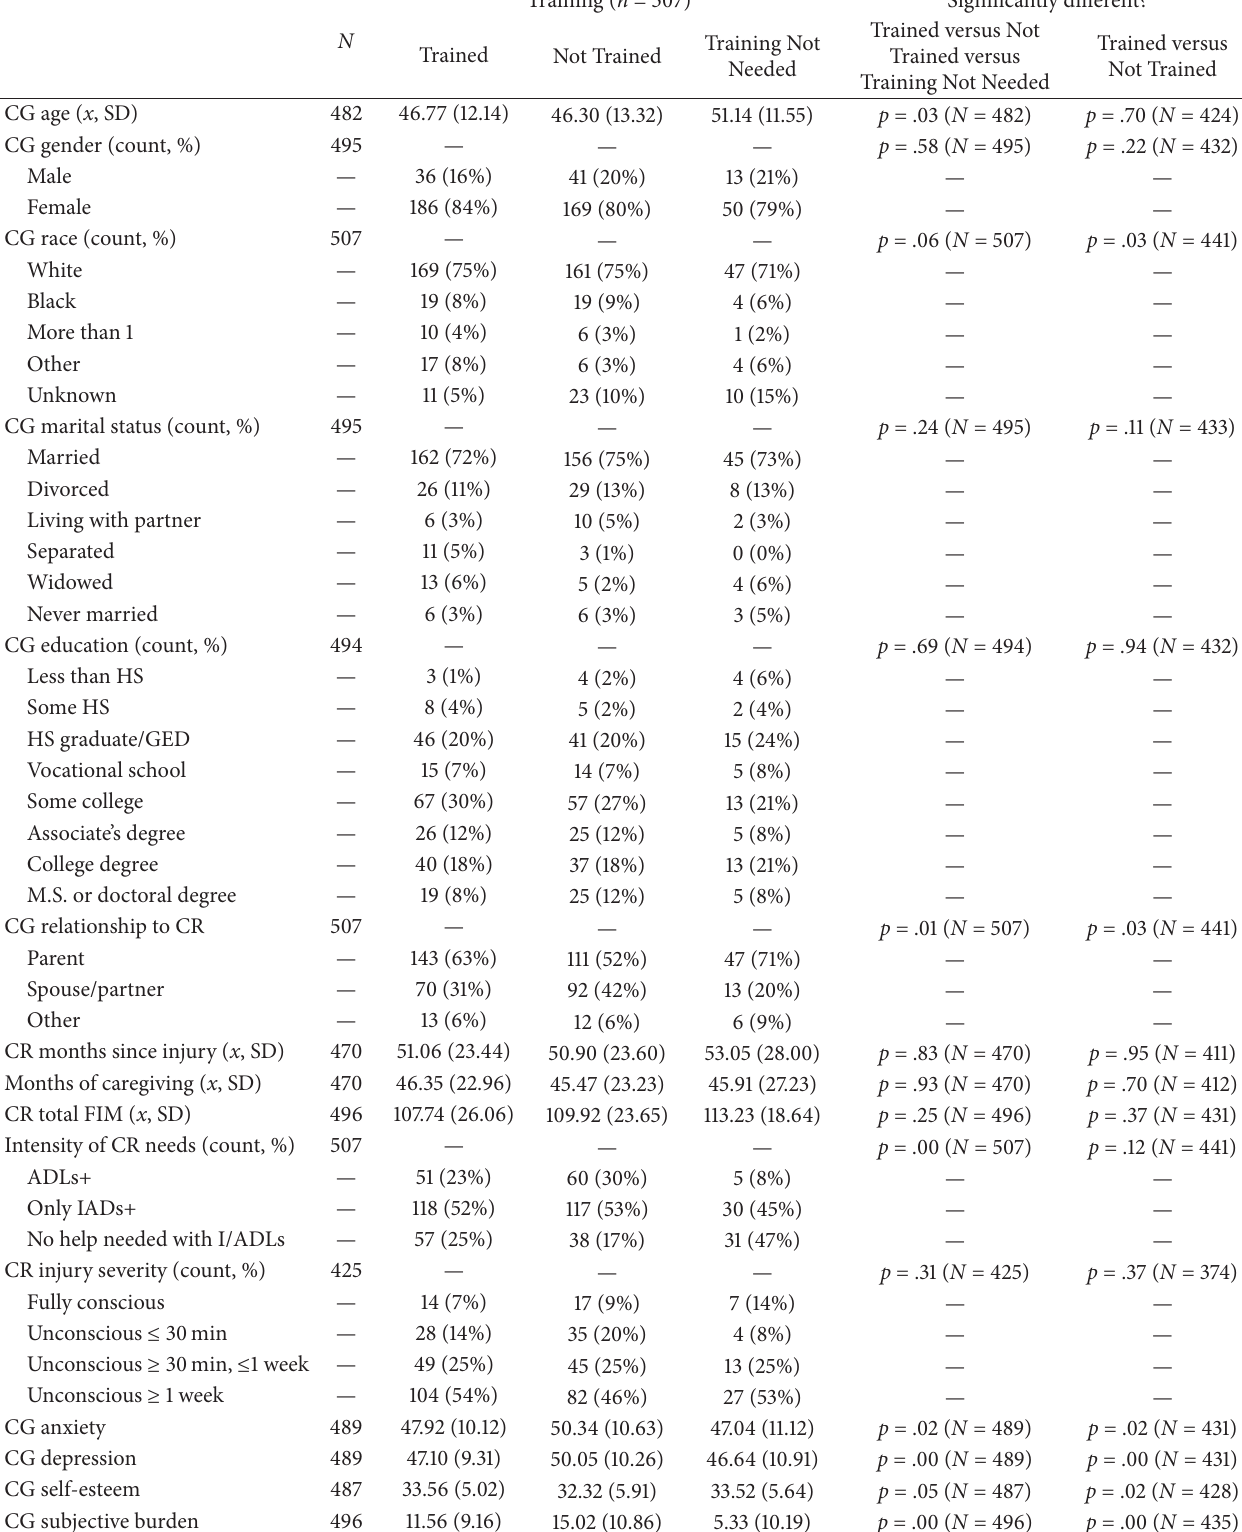
Table 5: Comparison of supporting emotions training groups on sociodemographics, injury and caregiver characteristics, and mental health outcomes.